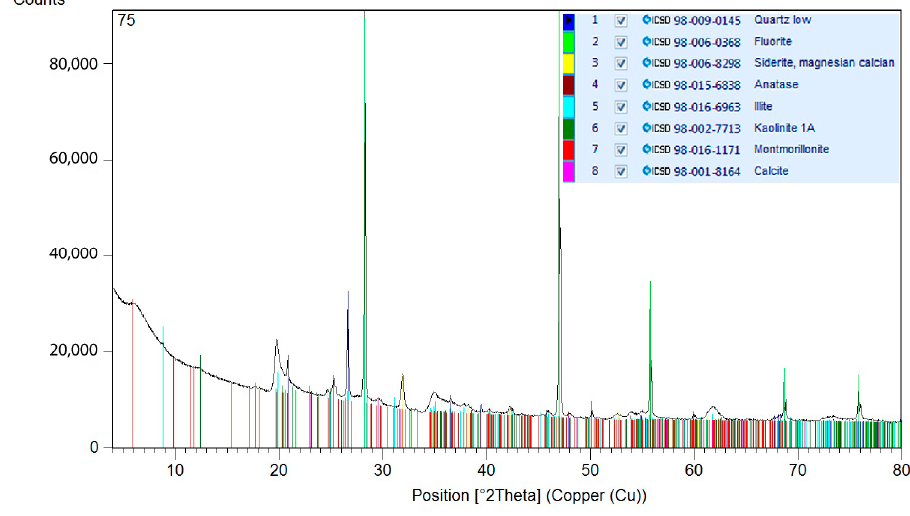
Figure 5. Diffractogram of Bentonit